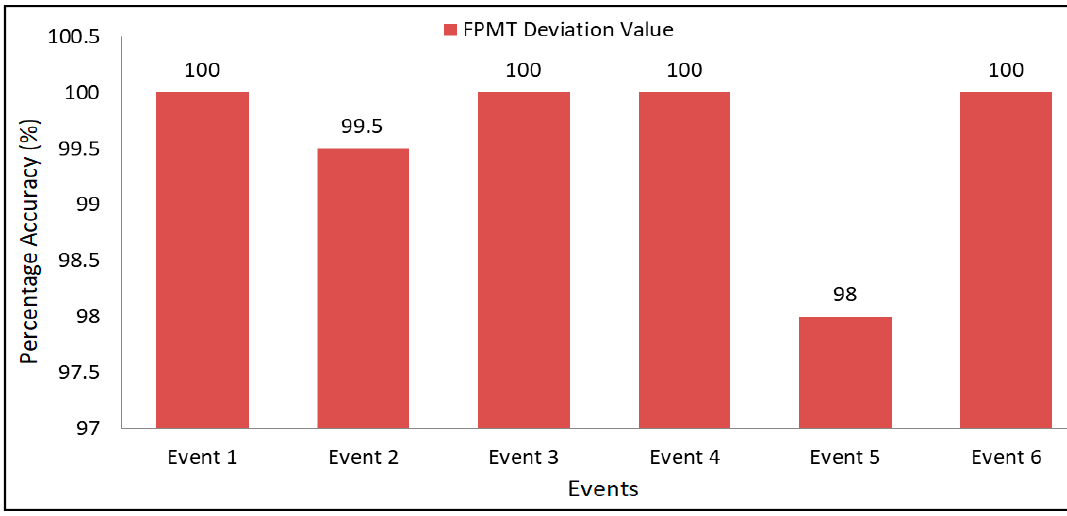
Figure 15. Improved FPMT technique measurement deviation.